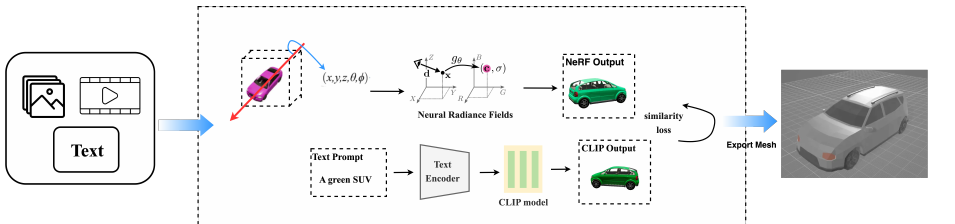
Figure 3. The pipeline of 3D content generation